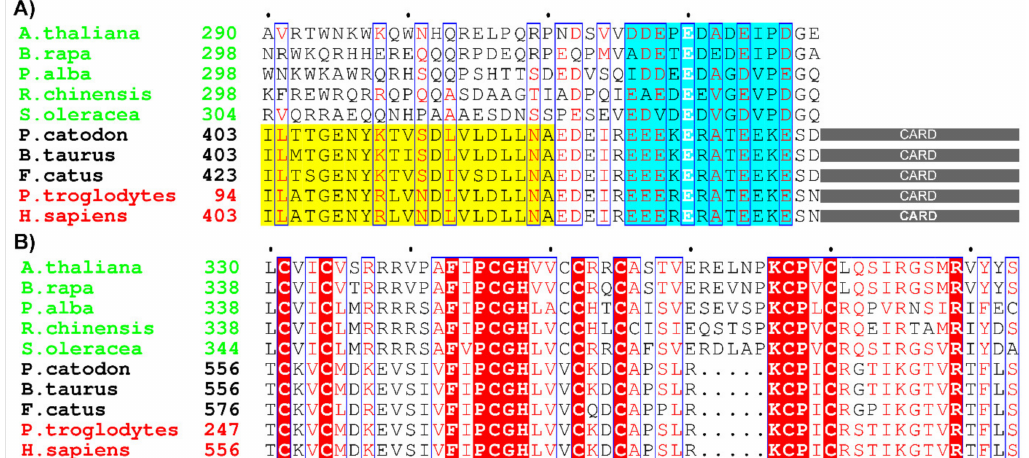
Figure 9. Selected sequences retrieved from BLAST searches of E3 ligases harboring LBT in plants (green), animals (black), and primates (red). ( A ) Lanthanide-binding motifs(cyan) present in some plant and animal E3 ligases. The ubiquitin- associated (UBA) domain of cIAP2 is highlighted in yellow. The caspase activation and recruitment domain (CARD) is shown as gray rectangles. ( B ) RING domains of selected E3 ligases. White letters on a red background represent strictly conserved residues; similar residues are shown as red letters on a white background in boxes.NCBI reference sequences are listed in Materials and